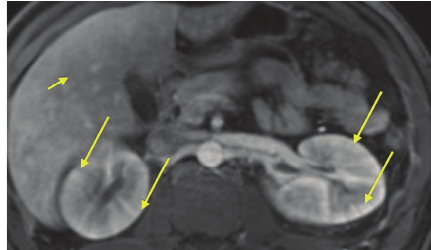
Figure 3: Axial fat-saturated T1w 20 second arterial phase contrast enhanced image: there is demonstration of heterogeneous enhance- ment of the renal cortex. Please note the “striated” appearance of the renal cortex (long arrows) which is also evident on 70- secondvenousphaseand180-seconddelayedvenousphaseimaging. Incidentally, the liver parenchyma also demonstrates heterogeneous enhancement (short arrow), consistent with inflammation.